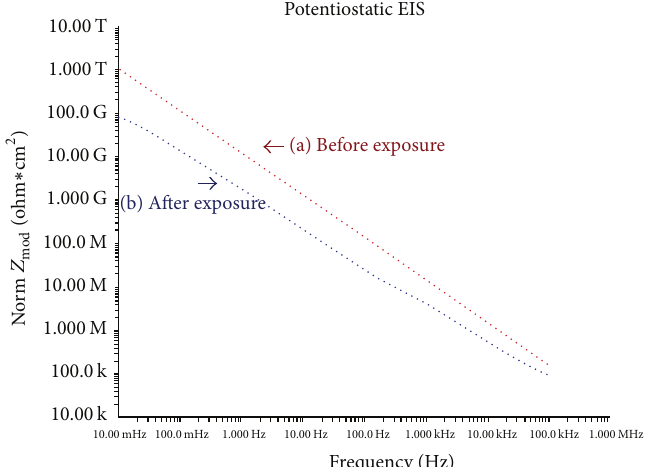
Figure 12: EIS Bode magnitude plots of the Fusion Bond Epoxy coating: (a) before and (b) after exposure to 5% NaOH solution for 30 days at 93 ∘ C/200 ∘